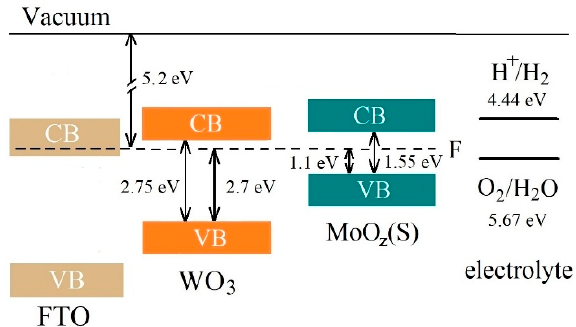
Figure 16. The proposed energy band diagram for MoO z (S) / WO 3 / FTO sample. The schema represents band offset between WO 3 with a thin MoO z (S) film. CB and VB indicate the conduction band and valence band, respectively.